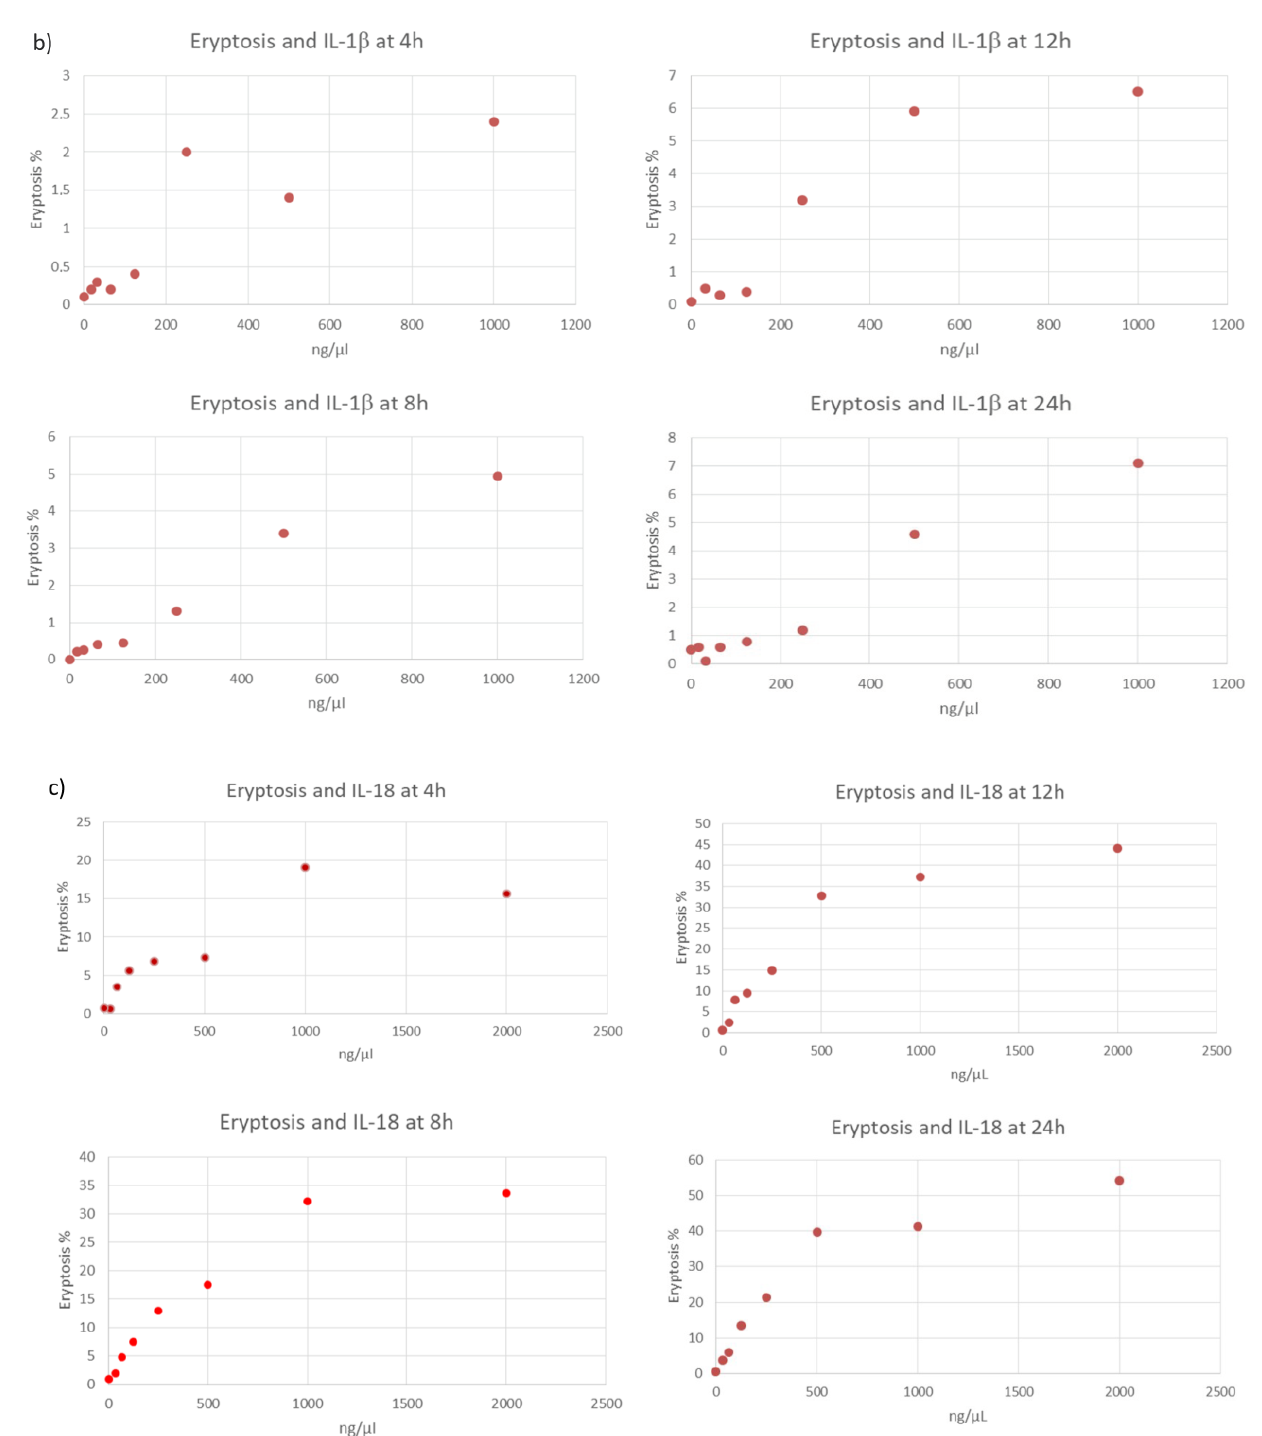
Figure 2. In vitro trigger of eryptosis by cytokines ( a ) IL-6, ( b ) IL-1 β , and ( c ) IL-18 at 4, 8, 12, and 24